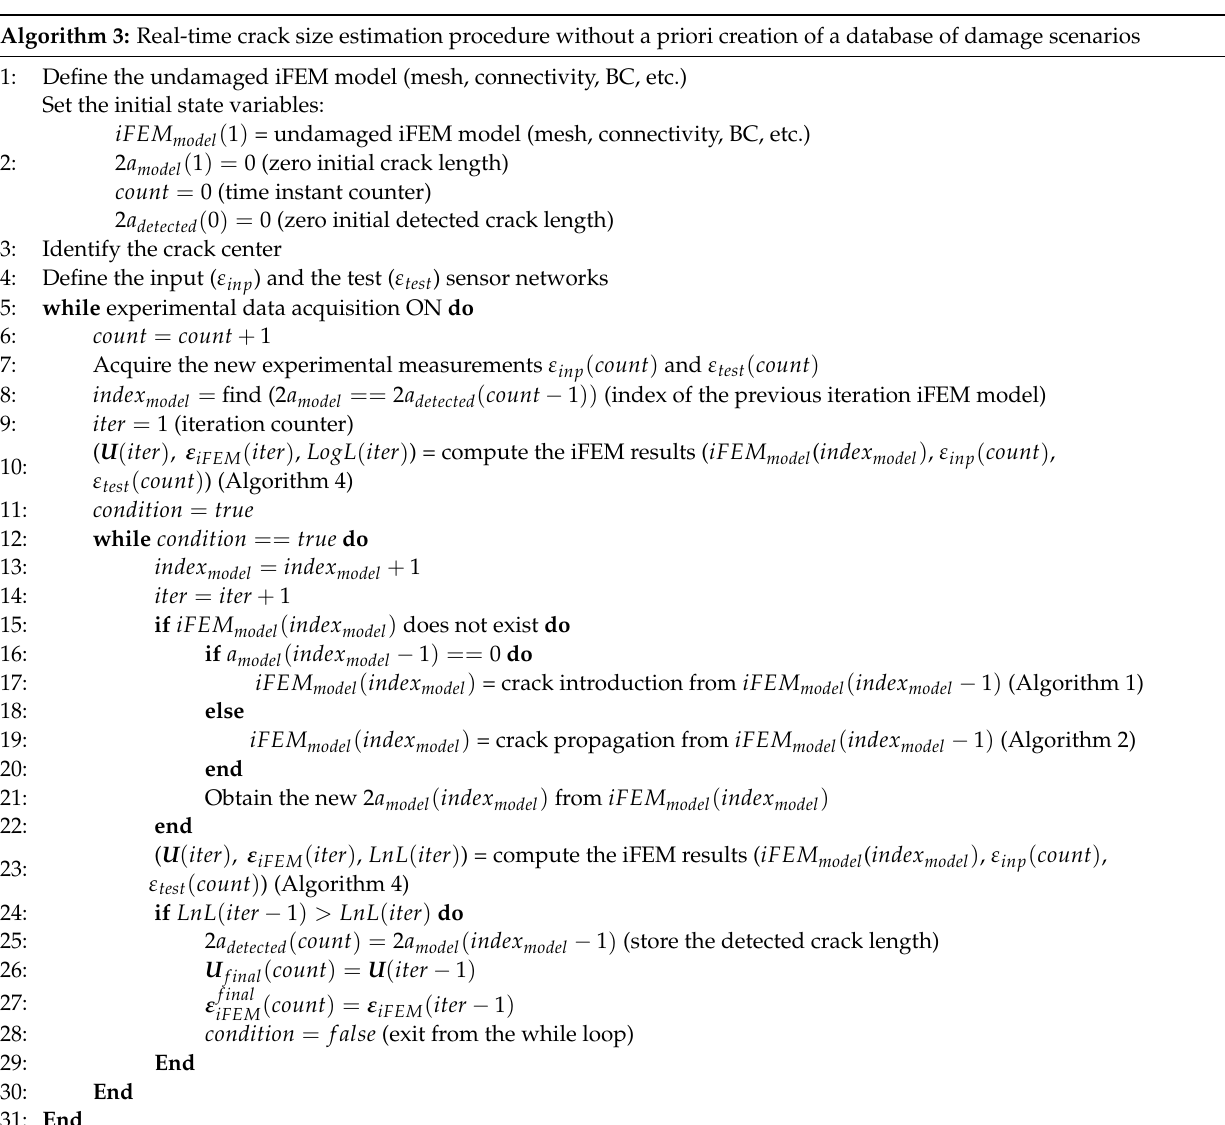
Algorithm 3: Real-time crack size estimation procedure without a priori creation of a database of damage